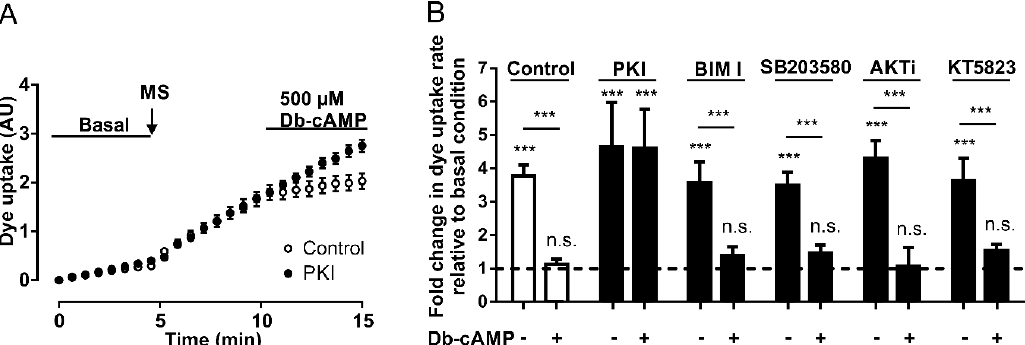
Figure 3. The inhibitory effect of Db-cAMP on Panx1 channel activity depends on PKA. ( A ) Temporary course of DAPI uptake in HeLa-Panx1 cells at basal condition, after mechanical stretch (MS, arrow) and during treatment with 500 µM Db-cAMP, pretreated with (black circles) or without (white circles) 20 µM PKI. ( B ) Normalized dye uptake rate in control HeLa Panx1 cells and cells pretreated with 20 µM PKI, 10 µM bisindolylmaleimide (BIM I), 10 µM SB203580, 10 µM AKTi or 10 µM KT5823, subjected to mechanical stretch and subsequently treated with 500 µM Db-cAMP. Statistical analysis in B was performed between each experimental group (connecting lines) and comparing each group with baseline (symbols above each bar): *** p < 0.001 and n.s., not significant. Each value in B corresponds to the average ± standard error of a total of three to five independent experiments.